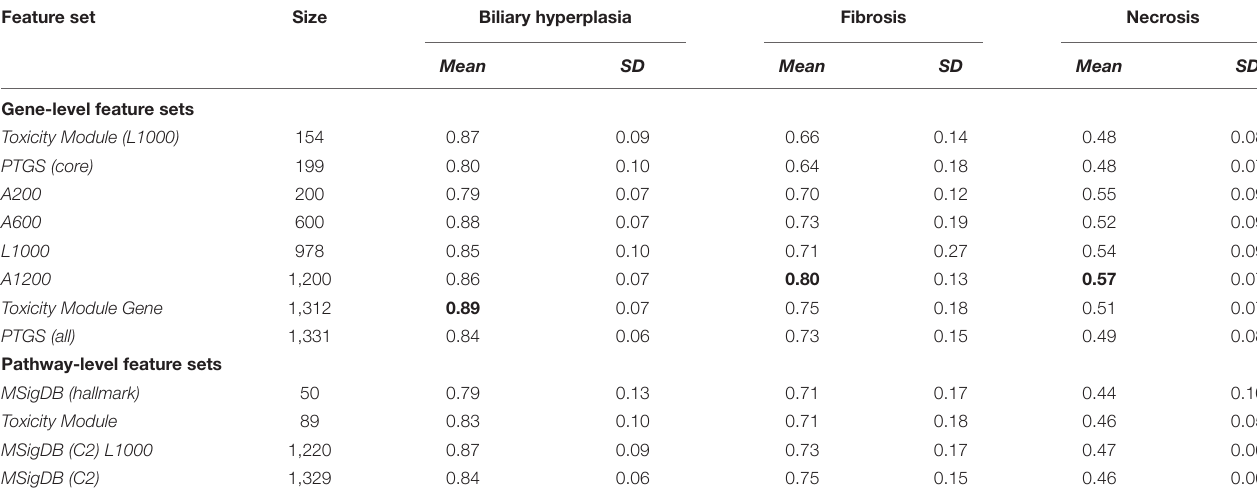
TABLE 4 | MCCs of SVM models on cross validation data.